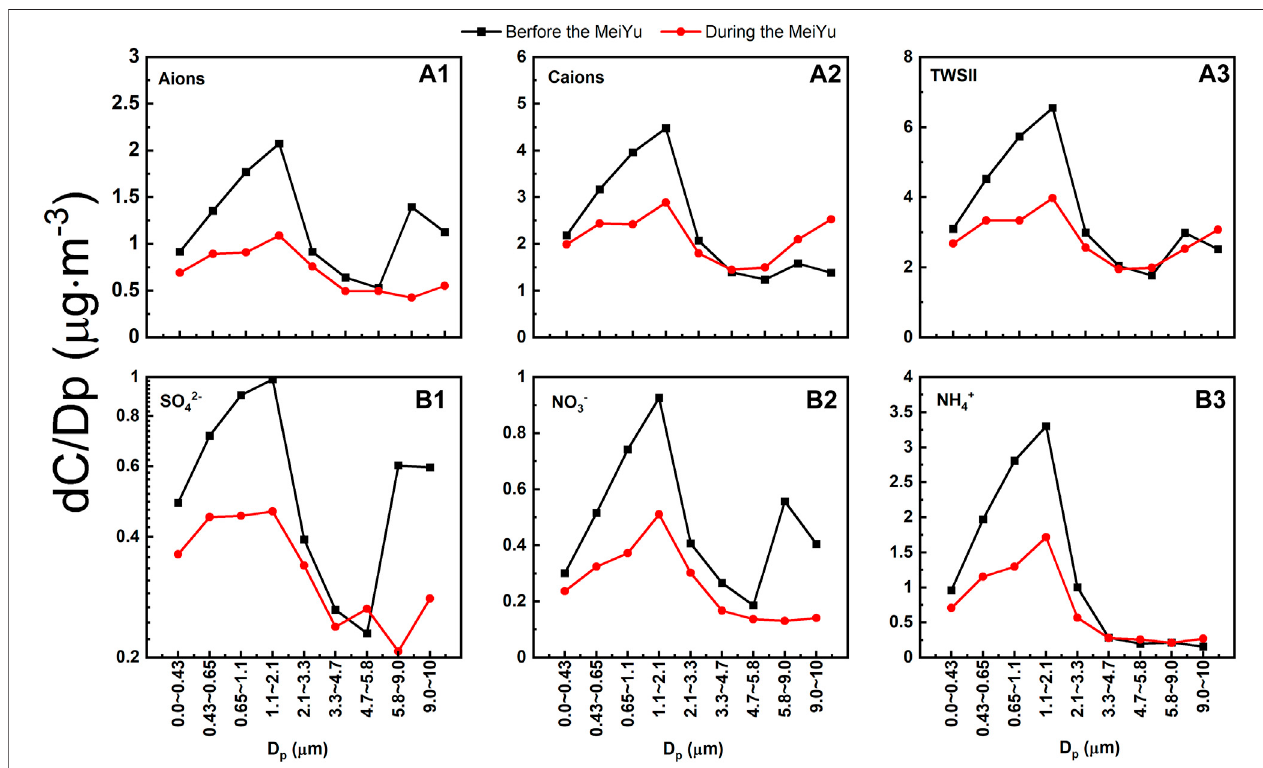
FIGURE 5 | Spectral distributions of water-soluble inorganic (a1) Aions (a2) caions (a3) ionic (b1) SO 42- (b2) NO 3 − , and (b3) NH 4+ at different periods.